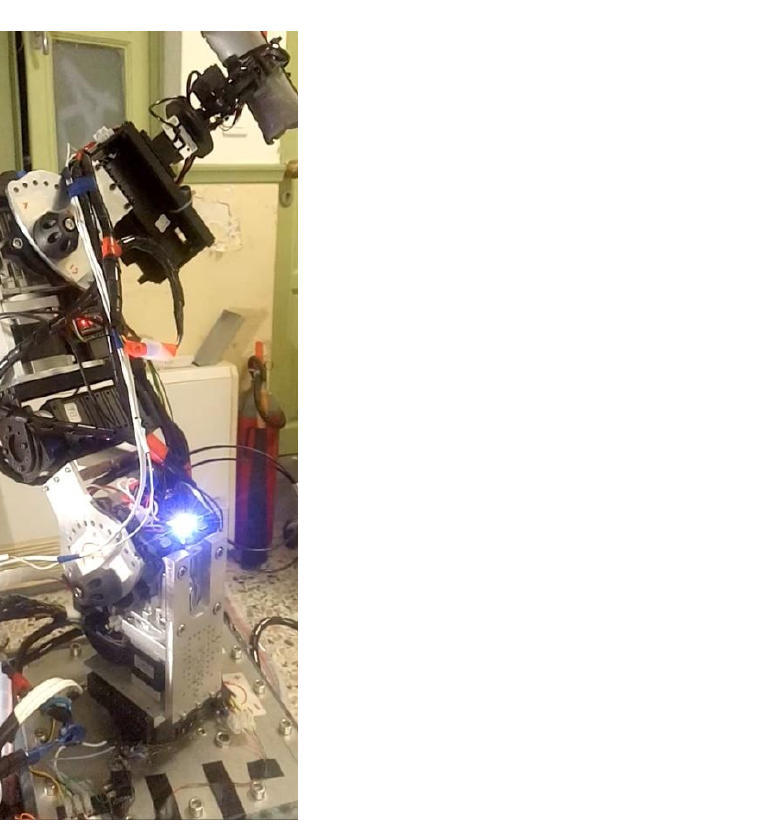
Figure 22. Optimal anatomy of the metamorphic manipulator derived under the MMA measure for Task 3.